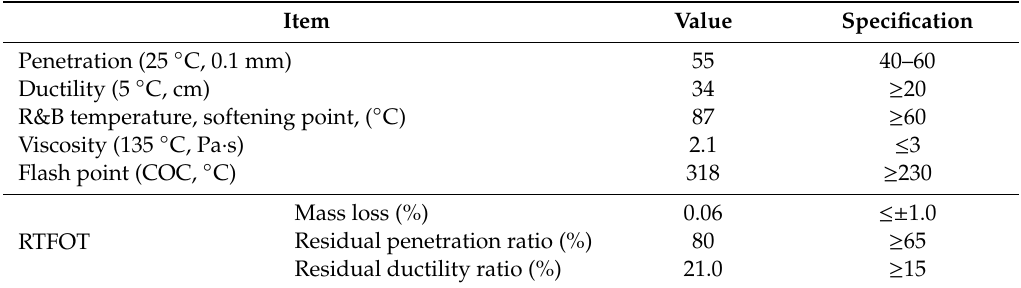
Table 1. Physical properties of Styrene Butadiene Styrene (SBS)-modified asphalt binders. Item